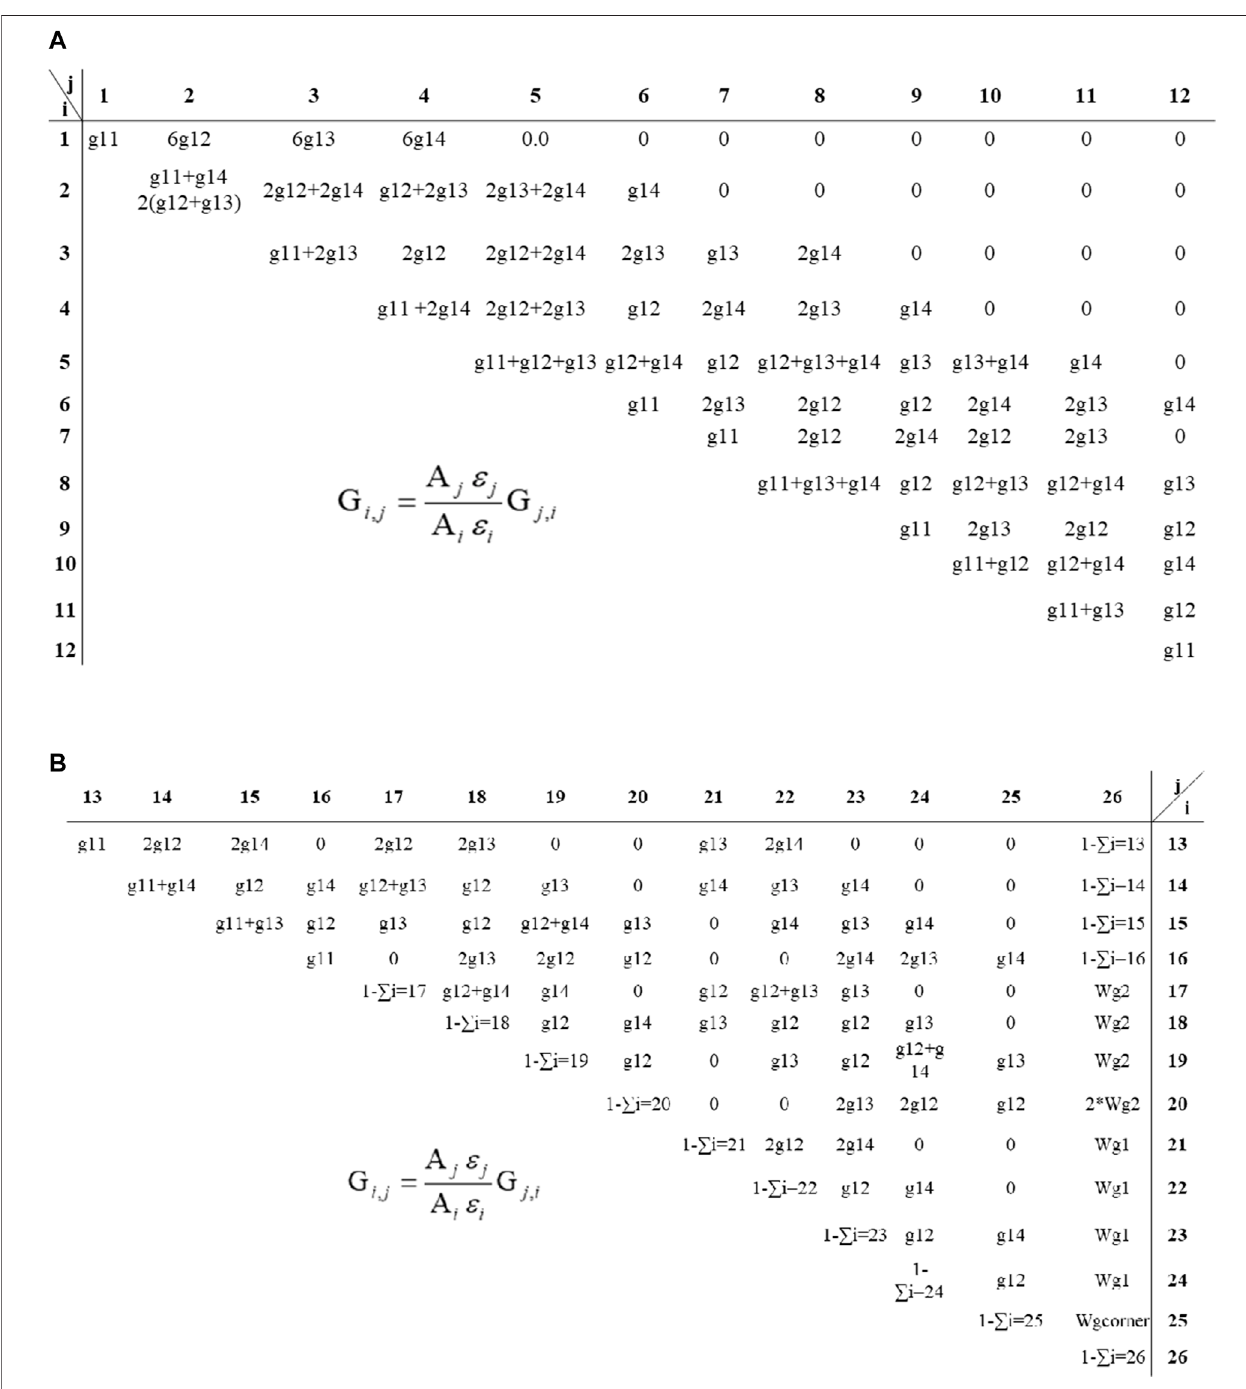
Frontiers in Energy Research |